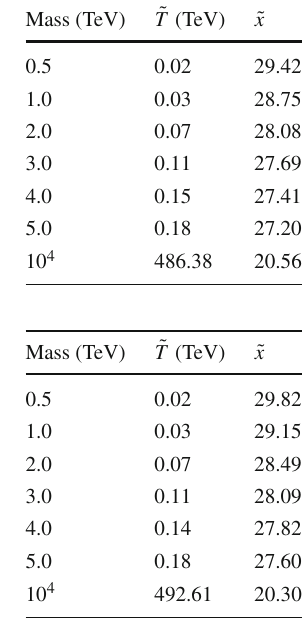
temperature ˜ T and ˜ x = m / ˜ T obtained from the condition in Eq. (21) for different values of the spin-zero monopole mass